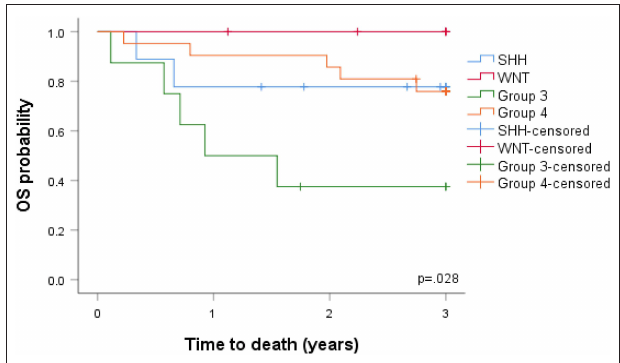
FIGURE 5 | Overall survival (OS) and progression-free survival (PFS) analyzed by the Kaplan-Meier method.